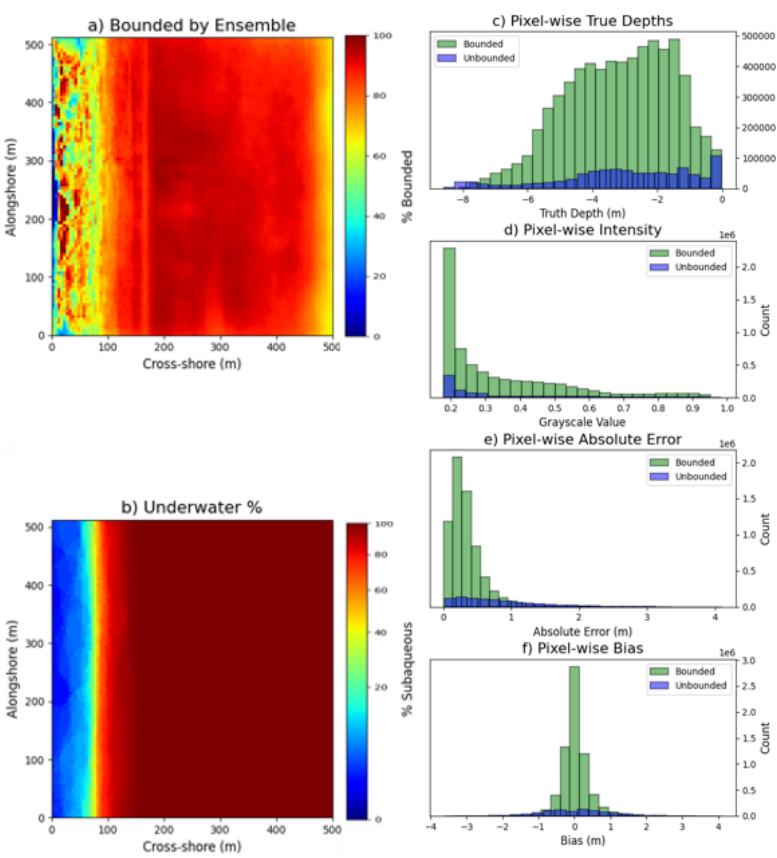
Figure 8. Uncertainty shown various ways over the test set. ( a ) A spatial map of each pixel that, when averaged across the test, shows the percentage of the time that the true depth at that pixel is bounded by the ensemble. ( b ) The spatial map of the number of times each pixel is under water in the test set of 895 images. ( c ) A histogram of each bounded and unbounded pixel. ( d ) The same pixel composition with the count of the errors of the bounded and unbounded pixels. ( e ) The same pixel composition with the count of the intensity of the bounded and unbounded pixels. ( f ) The same pixel composition with the count of the biases of the bounded and unbounded